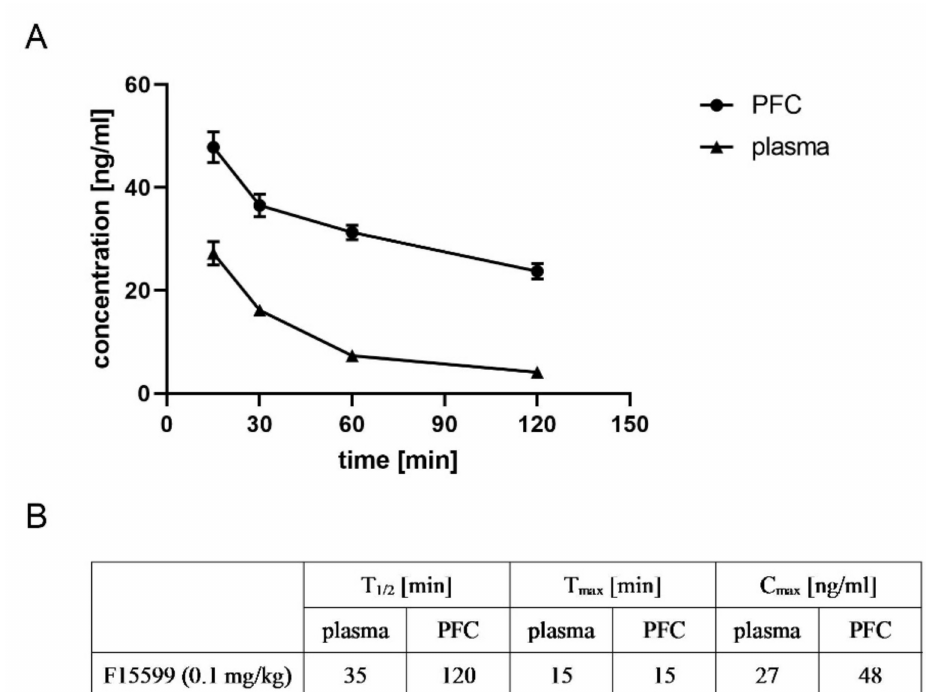
Figure 13. Pharmacokinetic analysis of the ability of F15599 to penetrate the frontal cortex. Time- dependent changes ( A ) and T 1/2 , T max and C max ( B ) are presented. F15599 was administered at a dose of 0.1